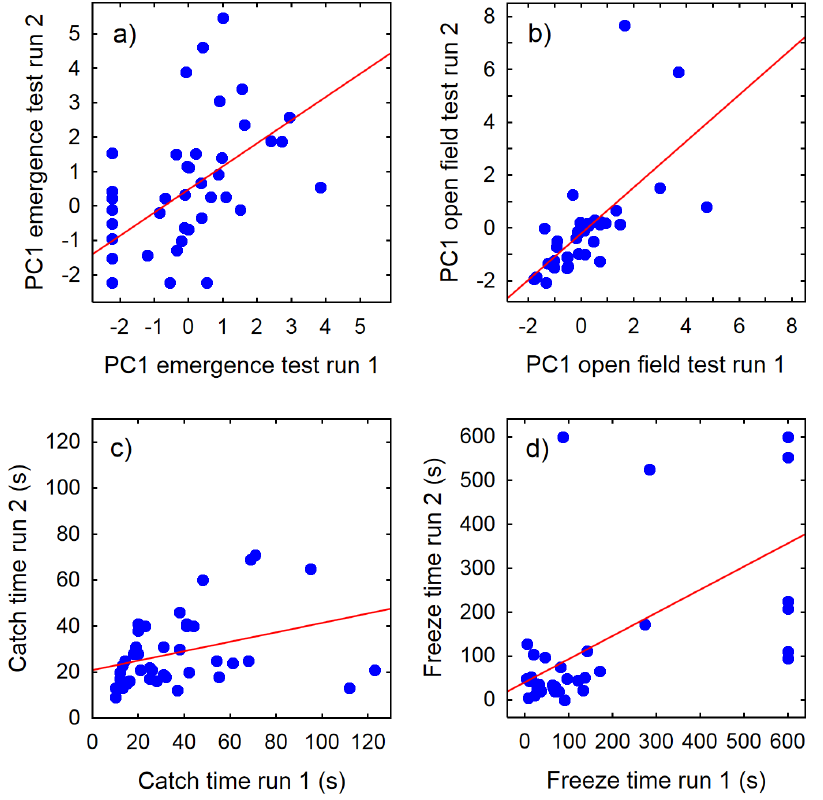
Figure 2. Correlations between behaviour in repeated tests of four boldness assays. a) Emergence test (PC1, r s =0.65, p , 0.001, N=44), b) Open field test (PC1, r s =0.80, p , 0.001, N=38), c) Catch time (r s =0.41, p = 0.007, N=42), and d) Freeze time (r s =0.55, p , 0.001, N=36) in two- spotted goby males.